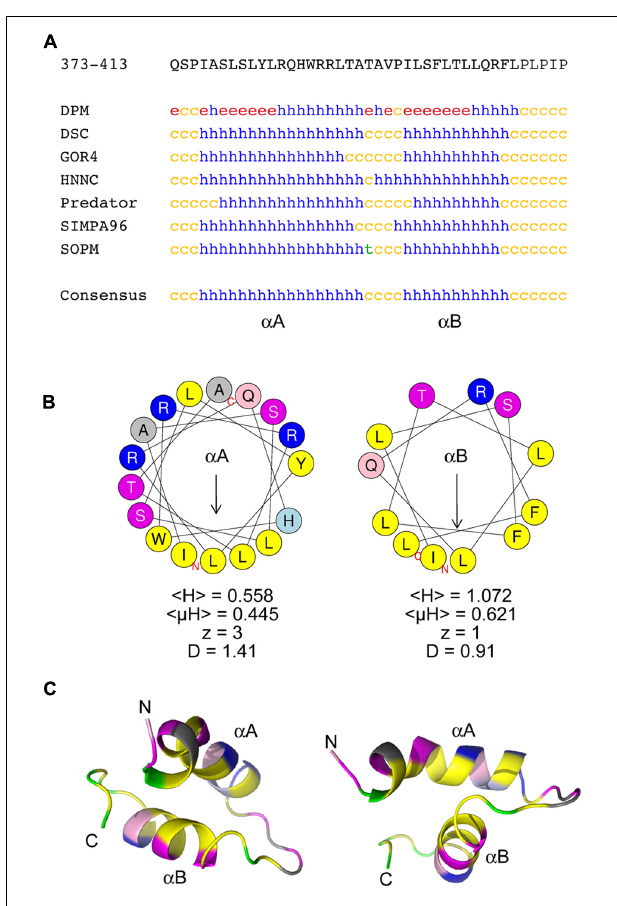
FIGURE 4 | The chloroplast targeting domain contains two predicted amphipathic alpha-helices. (A) Sequence and secondary structure predictions of the CTD domain within the 140K/98K protein. The sequence in one-letter code is shown at the top. Secondary structure predictions were made using several predictors from the NPS@ server (Combet et al., 2000). h: helix; c: coil; e: β -sheet; t: turn). The consensus prediction shown below identifies two α -helices designated α A and α B. (B) Helical wheel representation of α A and α B helices generated using the HeliQuest server (Gautier et al., 2008), illustrating the strong amphipathic character of both α A and α B. Yellow: hydrophobic residues; purple: serine and threonine residues; dark blue: basic residues; light blue: histidine residues; pink: glutamine residues; gray: other residues. The position of the first (N) and last (C) amino acids of the corresponding peptide sequences are indicated. For each helix, the mean hydrophobicity < H > , the mean hydrophobic moment < µ H > (in arbitrary units), the charge z and the discriminant factor D are also indicated. The length of the arrow is proportional to the mean hydrophobic moment < µ H > . (C) Ab initio modeling of the CTD using PEP-FOLD3 (Lamiable et al., 2016). The top model output is displayed as ribbons and colored with the same color code as in (B) , with proline residues in green. The position of the first (N) and last (C) amino acids of the corresponding peptide sequences are indicated. Two different views are shown to illustrate the importance of the linker sequence in the orientation of the helices relative to each other.